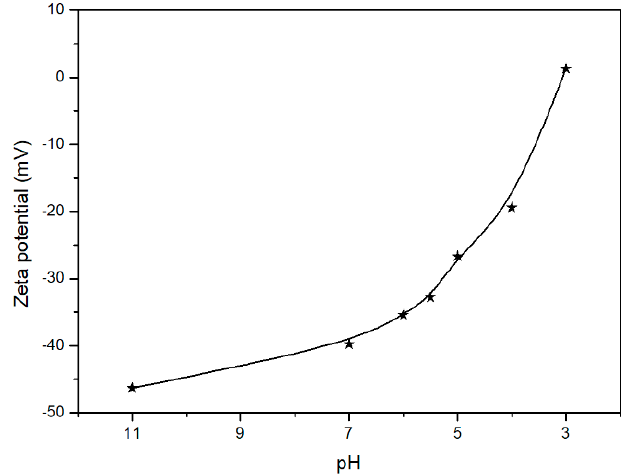
Figure 7. Zeta potential of PTHF acid solution at varying pH.